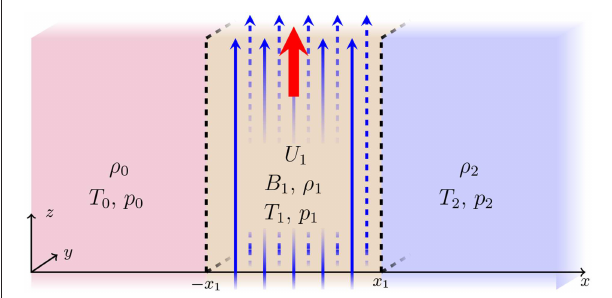
FIGURE 11 | The equilibrium configuration for a slab with two external